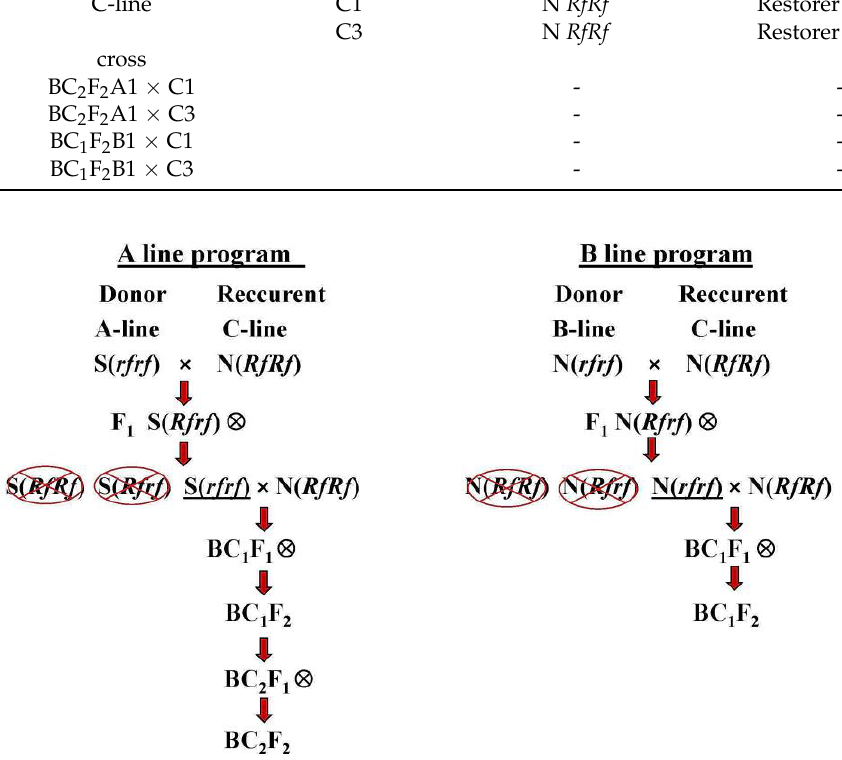
Figure 1. Backcross breeding with a recessive trait program for the development of male-sterile (A-line program) and maintainer lines (B-line program) by transferring genes to C-lines (elite restorer lines).